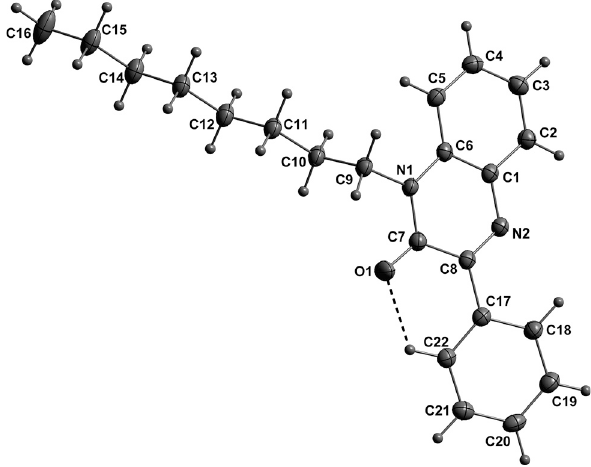
Table  : Data collection and